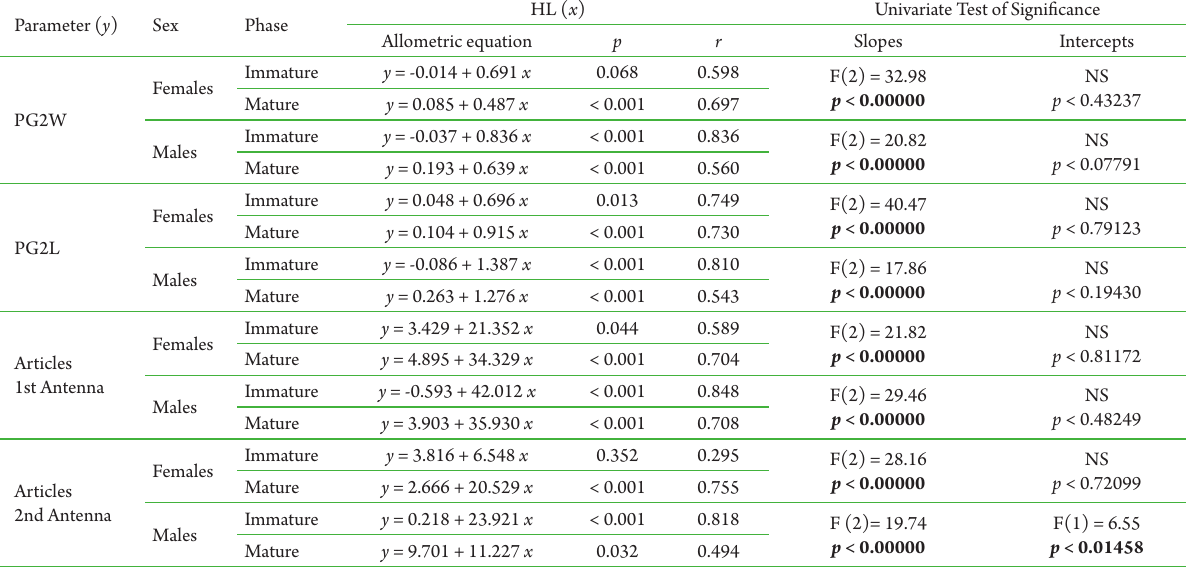
Table 2. Regression lines of the relative growth (allometric equation) of the width (PG2W) and length (PG2L) of the propodus of the second pair of gnathopods; and the number of articles of first and second pair of antennal flagella in the amphipod Quadrivisio lutzi. Significance of the allometric equation ( p < 0.05); correlation coefficient ( r ) of the two parameters. Univariate test of significance for the comparison of two regression lines (immature and mature phases); significance at p < 0.05. Regression for each phase was established by graphical observation, where males over 5 mm BL and females over 3 mm BL were considered mature.